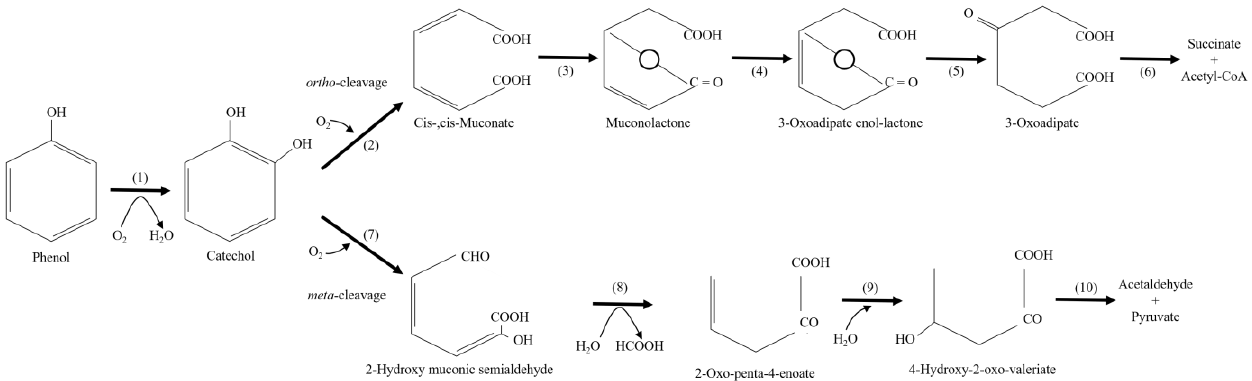
Figure 3. Aerobic phenol biodegradation pathways. (1) phenol monooxygenase, (2) catechol 1,2- dioxygenase, (3) muconate lactonizing enzyme, (4) muconolactone isomerase, (5) oxoadipate enol- lactone hydrolase, (6) oxoadipate succinyl-CoA transferase, (7) catechol 2,3-dioxygenase, (8) hydroxymuconic semialdehyde hydrolase, (9) 2-oxopent-4-enoic acid hydrolase, (10) 4-hydroxy-2-oxovalerate aldolase [125].